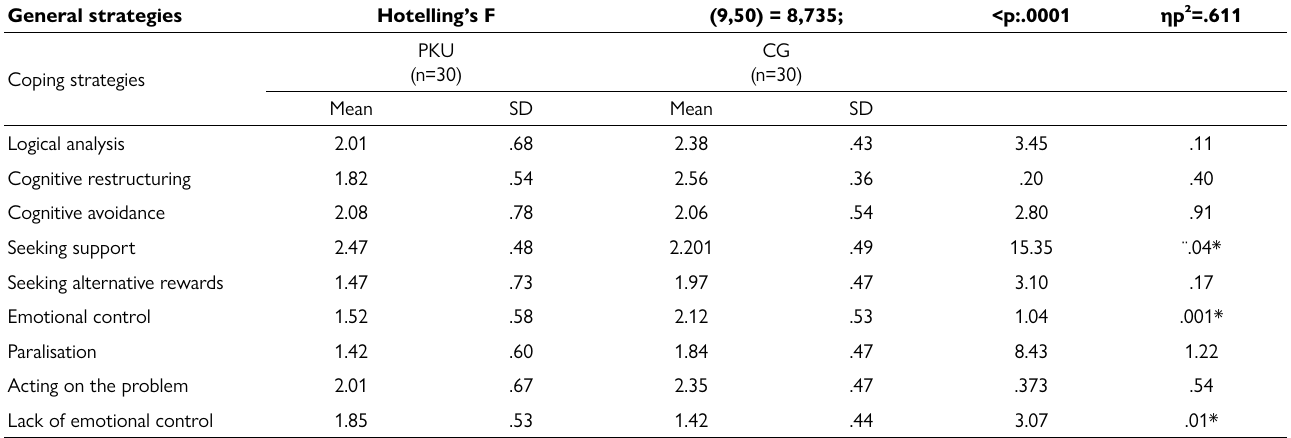
Table 3. Coping strategies found in the 30 studied PKU children vs the control group